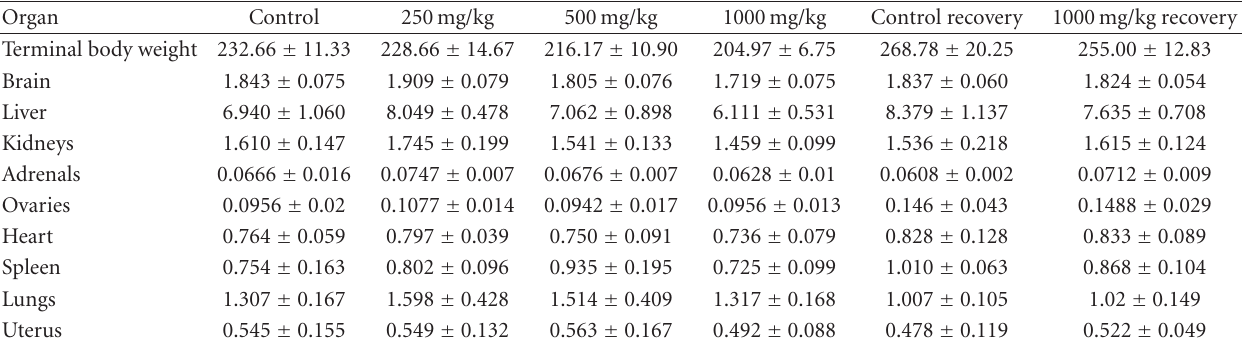
Table 7: Absolute organ weights (g; mean ± SD) in female rats after 90 days subchronic oral administration of Zigbir (cid:2) . Organ Control 1000 mg/kg recovery Terminal body weight 232.66 ±